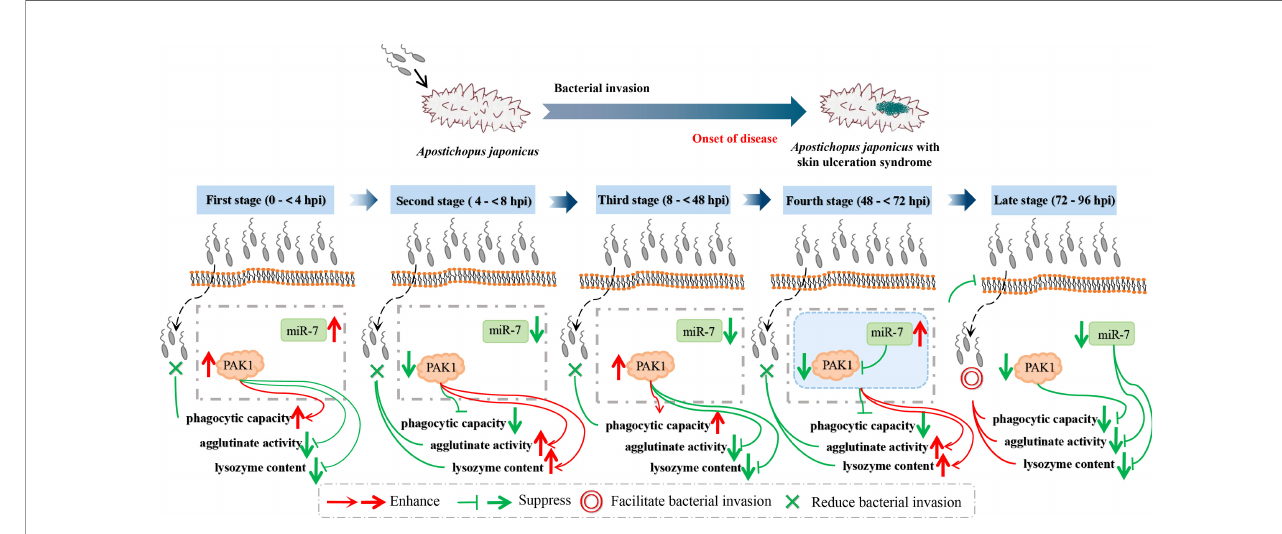
FIGURE 6 | Schematic diagrams of AjPAK1 and miR-7 involved in host-pathogen interaction of Apostichopus japonicus